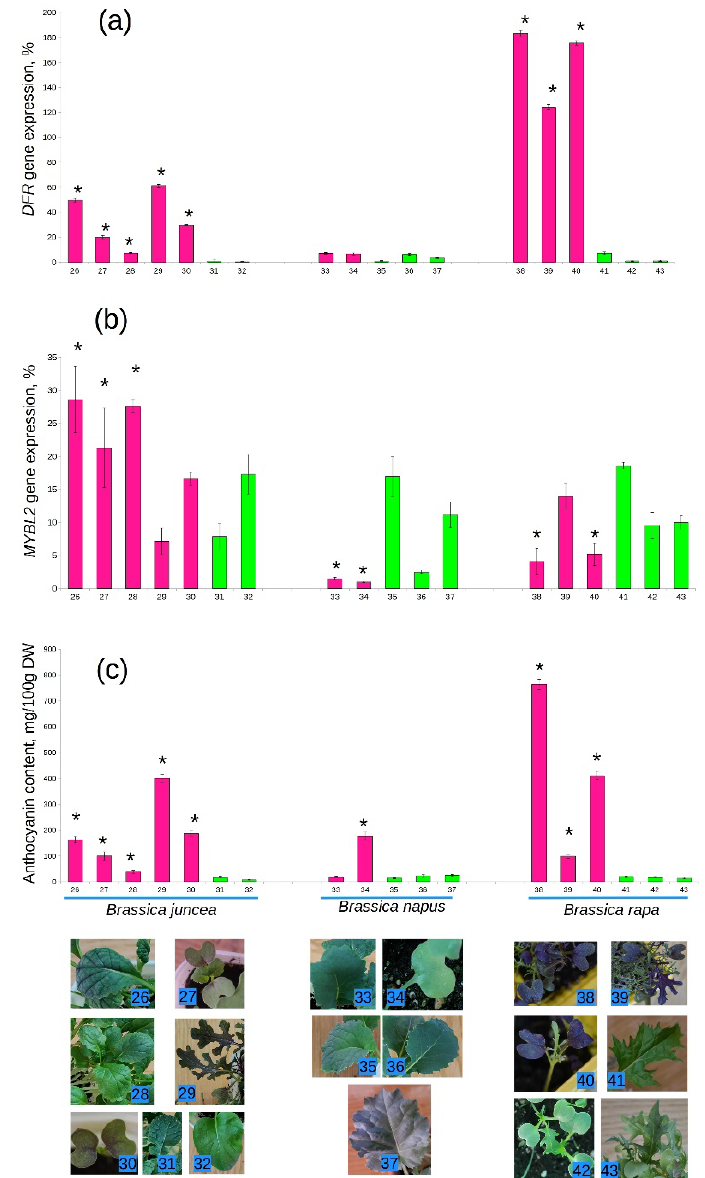
Figure 2. Relative expression level of the DFR gene ( a ), MYBL2 gene ( b ) and anthocyanin content ( c ) in purple and green cultivars of B. juncea , B. napus , and B. rapa . Visible pigmentation is shown in the photographs. Cultivars are numbered as follows: 26—Vitamin; 27—Red velvet; 28—Freckle; 29—Miracles in the sieve; 30—Red giant; 31—Wavelet; 32—Vigorous; 33—rutabaga Krasnosel- skaya; 34—rutabaga Gera; 35—rutabaga Novgorodskaya; 36—rutabaga Child love; 37—fodder cabbage Veha; 38—Ruby little mermaid; 39—Mizuna Red; 40—Mizuna purple; 41—Impulse; 42—The little mermaid; 43—Mizuna green. Varieties declared as purple are highlighted in pink. Asterisk (*) indicates a significant difference from unpigmented plants of the same